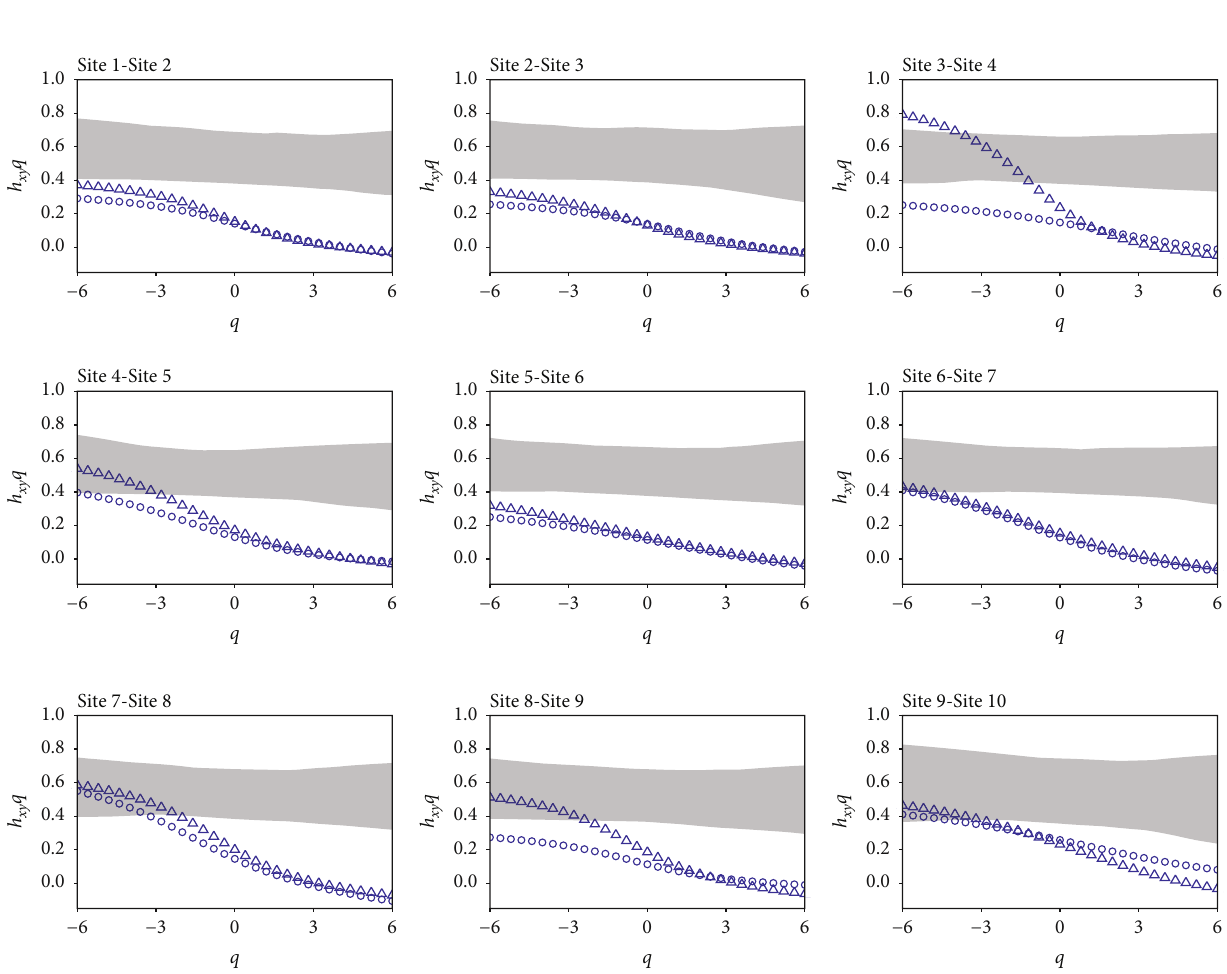
Figure 4: Testing via pair of surrogate series ( X ( t ) ,Y ( t )) 􏽮 􏽯 . X -axis denotes the range of q values. Triangles indicate h sg 1 sg 1 preprocessed daily average river levels at adjacent sites. Circles indicate h XYS ( q ) s obtained via simultaneously half-shifting technique. The shadow area indicates acceptance region of h XY ( q ) at 5% significance level estimated from 1000 pairs of surrogate series for the null : the joint multifractality is not due to the correlations within and between series. hypothesis H 0 sg 1